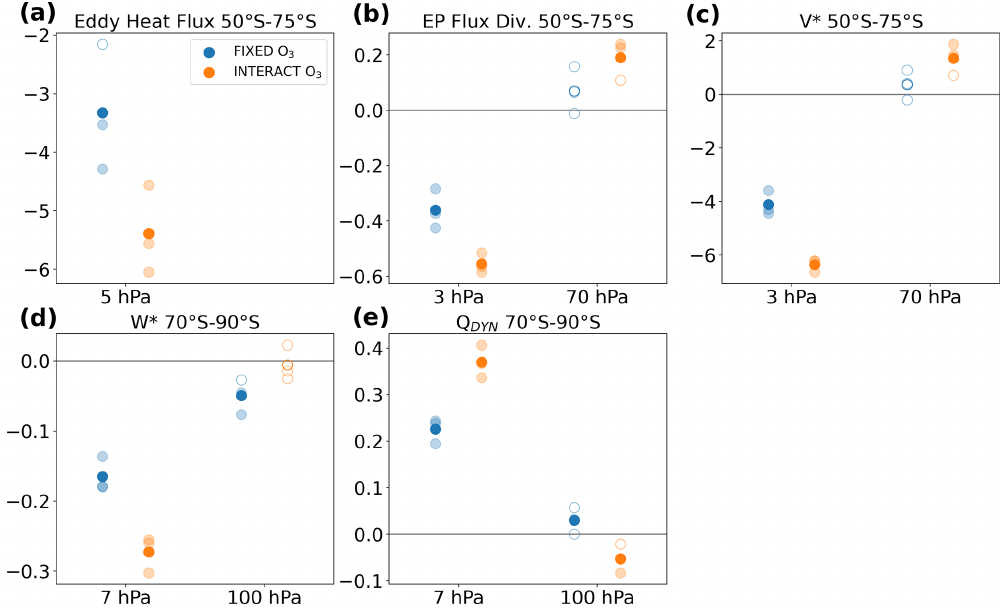
Figure 13. Trends in November eddy heat flux ( a ; Kms − 1 per decade), EP flux divergence ( b ; ms − 1 d − 1 per decade), meridional residual velocity ( c ; cms − 1 per decade), vertical residual velocity ( d ; mms − 1 per decade), and dynamical heating rate ( e ; Kd − 1 per decade). The eddy heat flux, EP flux divergence, and meridional residual velocity are averaged over 50–75 ◦ S, and the vertical residual velocity and the dynamical heating rate are averaged over 70–90 ◦ S. FIXED O 3 trends are shown in blue, and INTERACT O 3 trends are shown in orange. Ensemble mean trends are depicted by the dark-colored circles, while the individual member trends are depicted in faded colors. Trends that are significant at the 95% confidence level are marked by filled